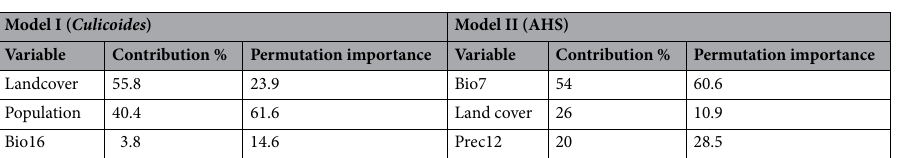
Table 2. Estimates of contributions of important predictor variables to the model.